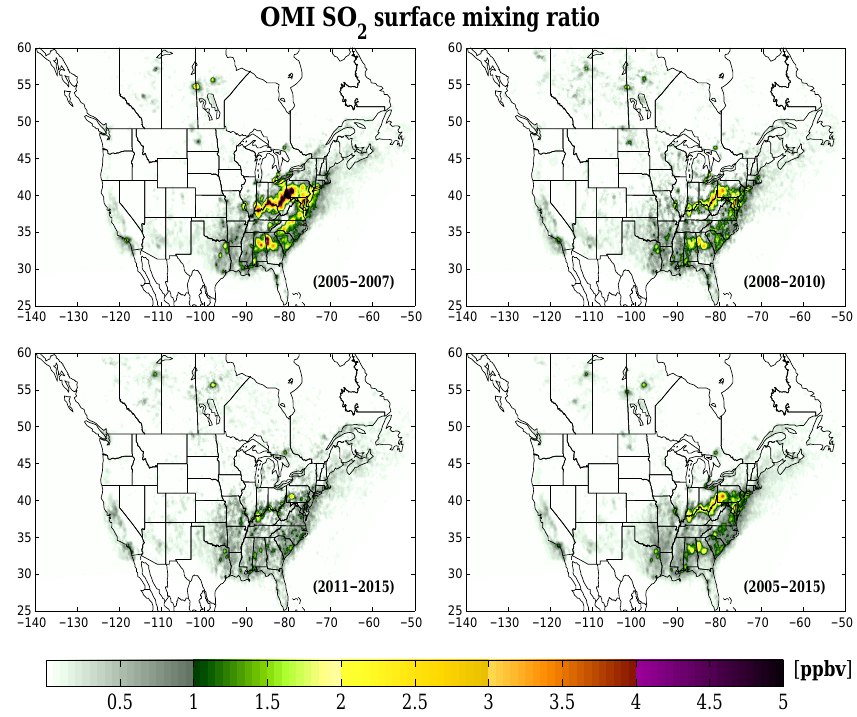
Figure 1. Spatial distribution of the mean OMI-derived ground-level SO 2 mixing ratio over North America for the periods of 2005–2007,